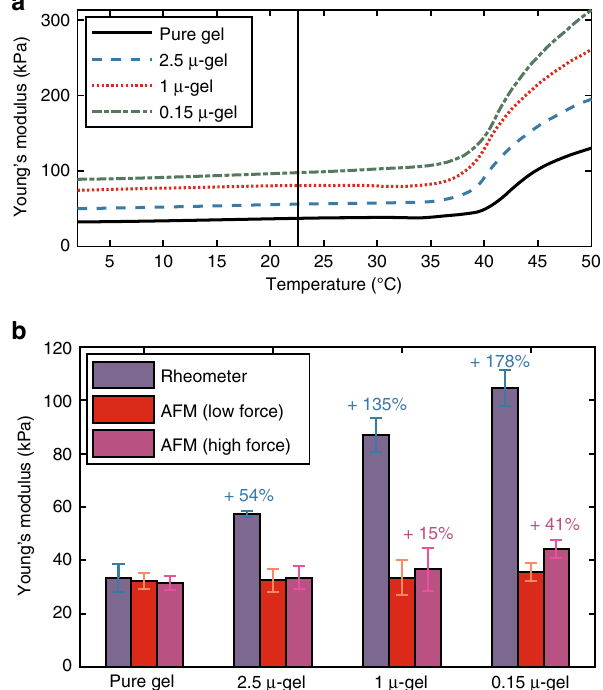
Fig. 1 Comparison between microscopic and macroscopic Young ’ s modulus. a Rheological shear modulus measurements converted to Young ’ s modulus using n = 0.5 → E = 3G on composite hydrogel series with temperature sweep. Data were converted from shear modulus to Young ’ s modulus for direct comparison with AFM results. b Rheometer results in comparison with spherical colloidal probe AFM analyzed at low (0.2 – 20nN) and high (40 – 60nN) force in suf fi cient distance from visible particles. Error bars represent the quadrature sum of single measurements uncertainty and standard deviation of 10 replicates obtained at different macroscopic